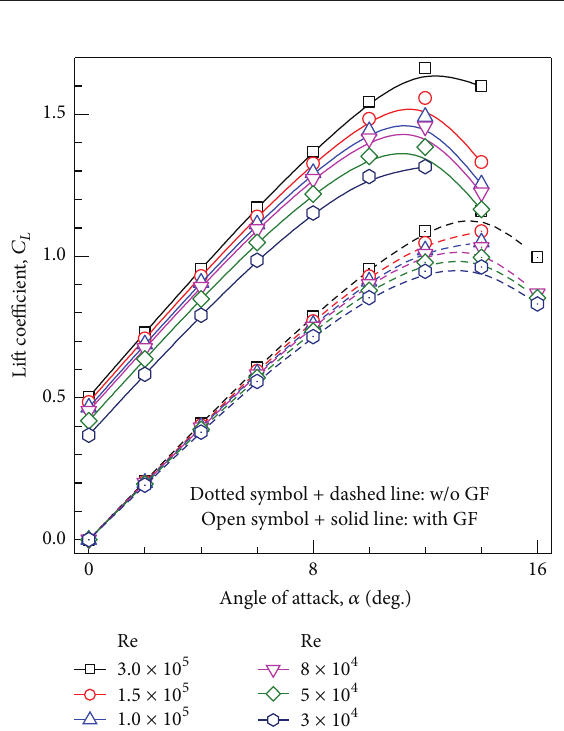
Figure 3: Variation of 𝐶 𝐿 with AoA for different Reynolds numbers for the airfoil without and with